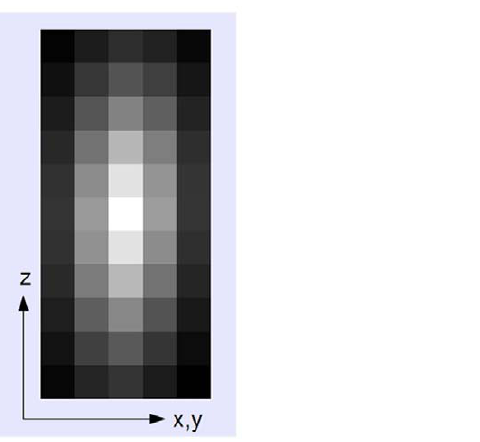
Figure 6. Matching template. Example for an automatically generated matching template in the x-z plane. The blurring is largest in the z direction.